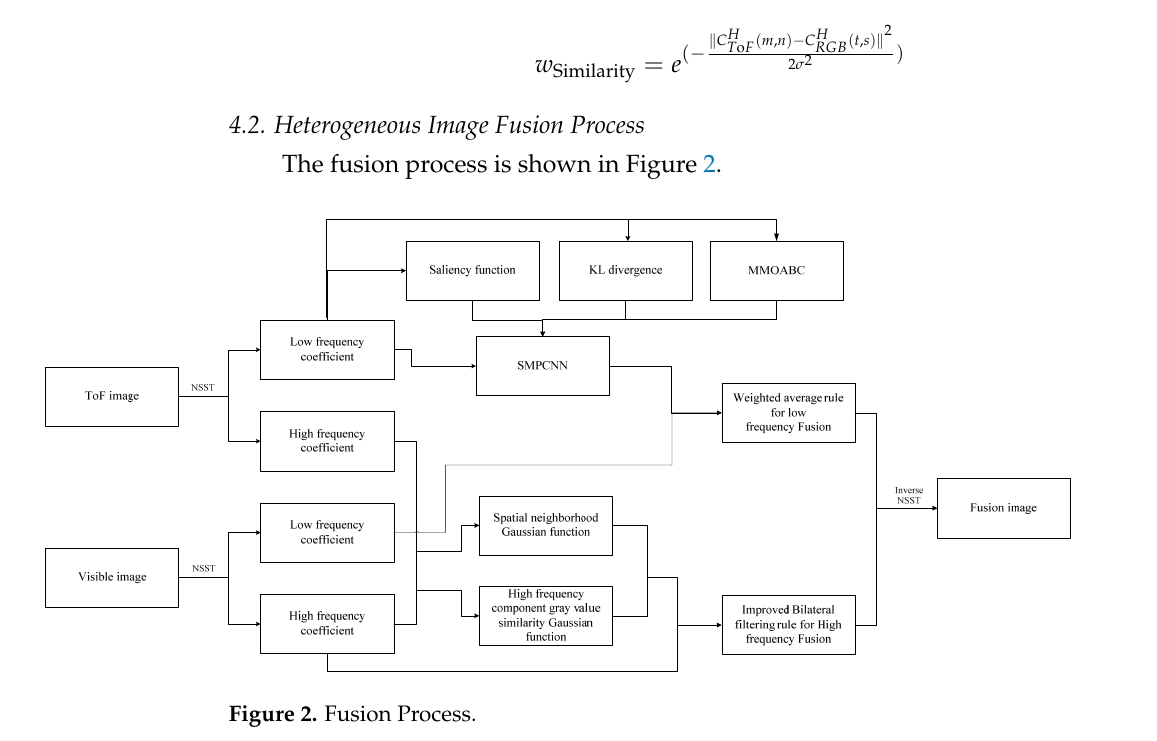
Figure 2. Fusion Process.